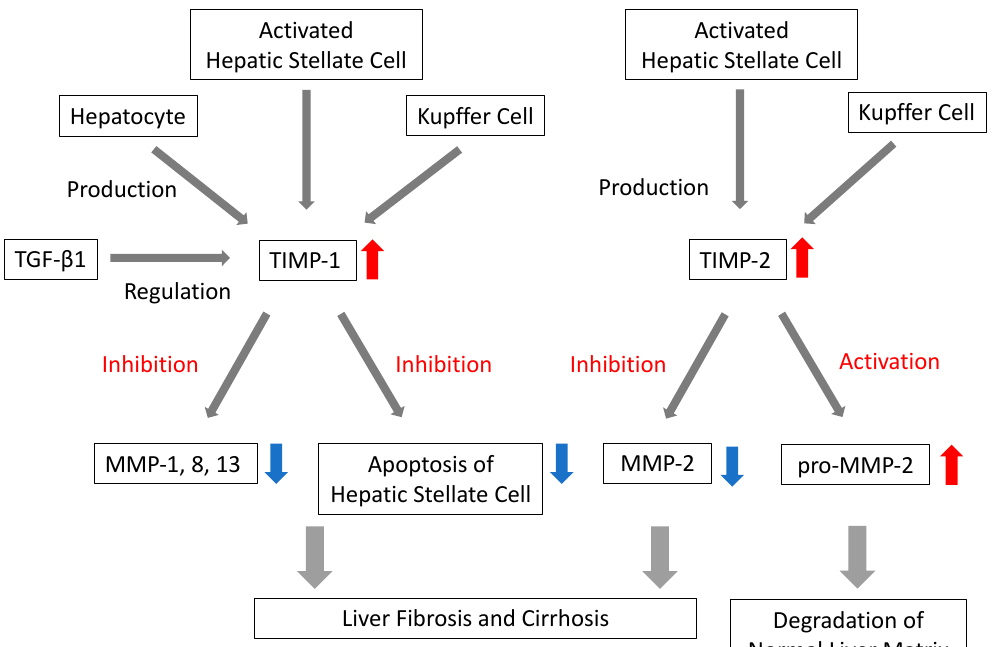
Figure 2. Representative mechanism of matrix metalloproteinase (MMP) and tissue inhibitor of metalloproteinase (TIMP) in liver fibrosis. Red arrows indicate activation, blue arrows indicate inhibition. TGF- β 1, transforming growth factor β 1. TIMP-1 is produced by activated stellate cell, hepatocyte, and Kupffer cell. TIMP-1 is regulated by TGF- β 1 and inhibits collagenase (MMP-1, 8, 13) and apoptosis of hepatic stellate cell, causing liver fibrosis and cirrhosis. TIMP-2 is produced by activated stellate cell and Kupffer cell. TIMP-2 inhibits MMP-2 and also activates pro-MMP-2, causing degradation of normal liver matrix. Table 4. Summary of matrix metalloproteinases (MMPs).